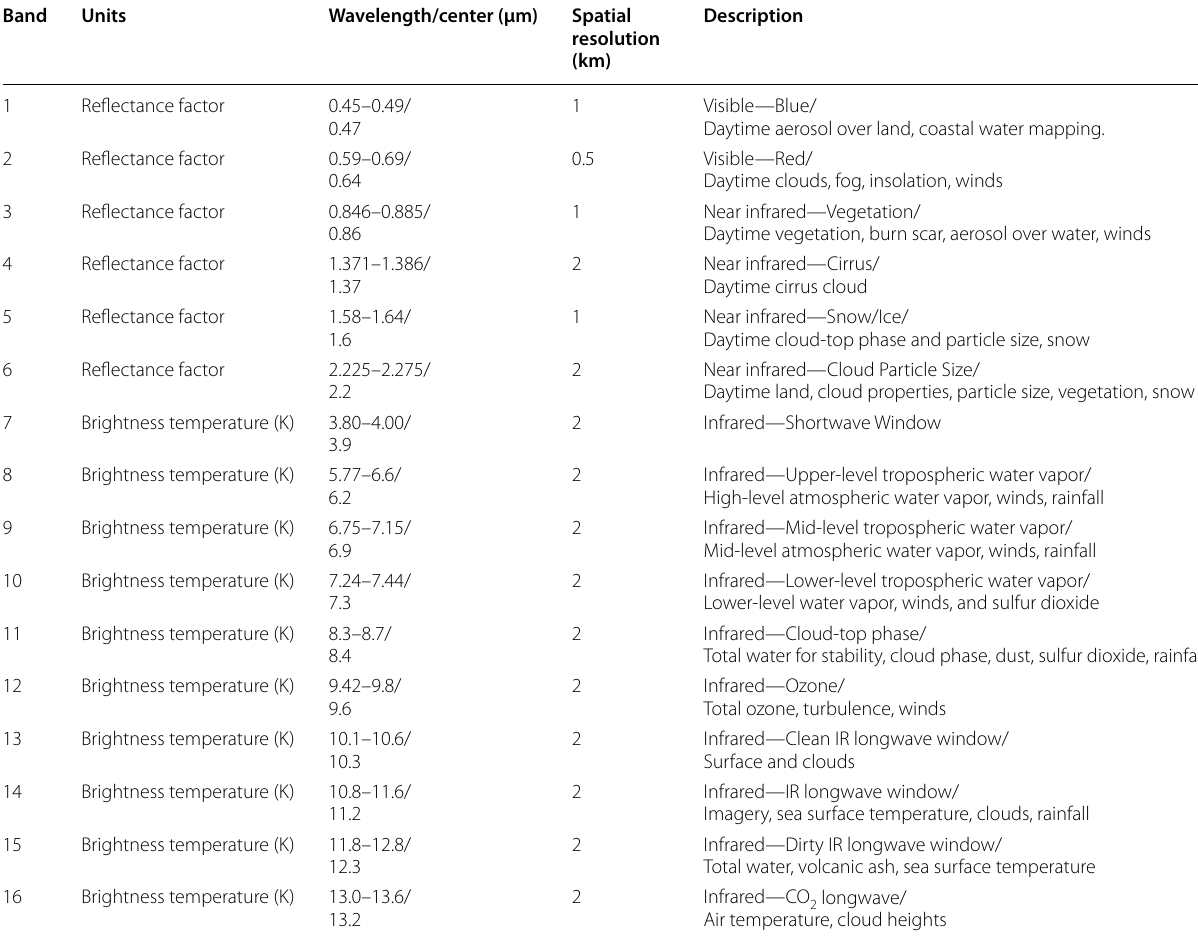
Table 1 Band characteristics for the GOES-R Advanced Baseline